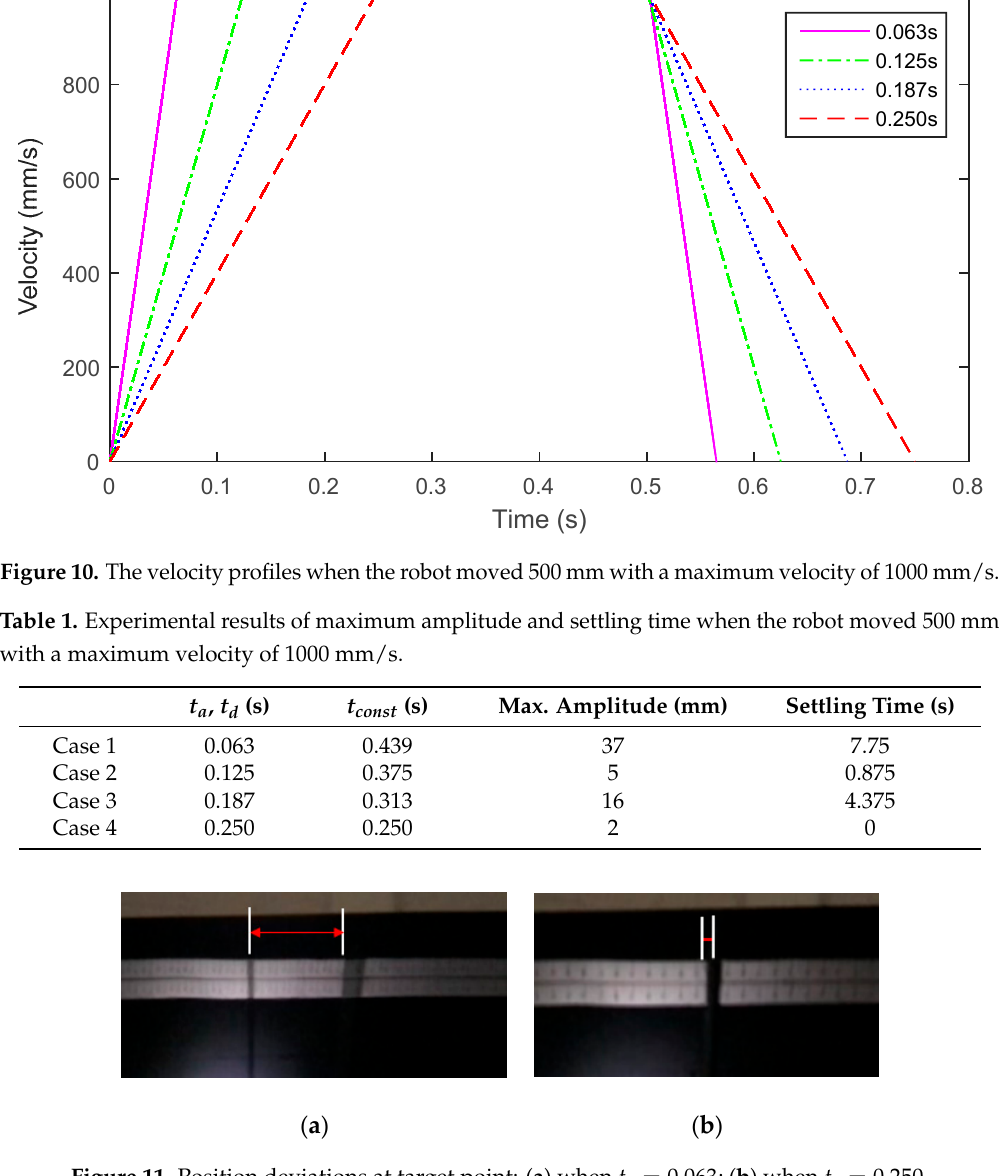
Figure 11. Position deviations at target point: ( a ) when 𝑡 (cid:3028) = 0.063 ; ( b ) when 𝑡 (cid:3028) = 0.250 .